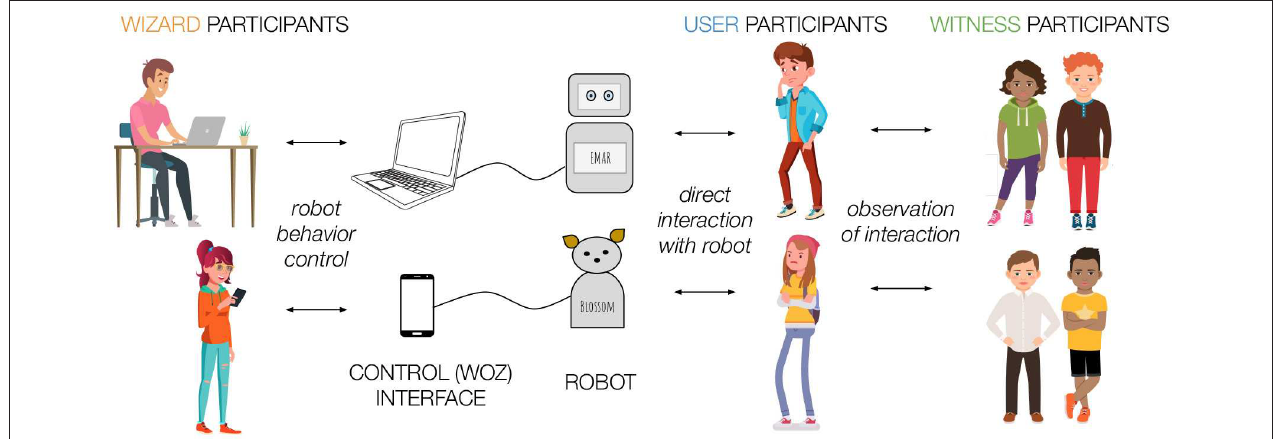
FIGURE 1 | Illustration of the Participatory Wizard of Oz in the Wild Method used in our research. Wizards control robot behavior, users directly interact with the robot, and witnesses observe user-robot interaction. design partner, our Participatory WoZ (PWoZ) method was